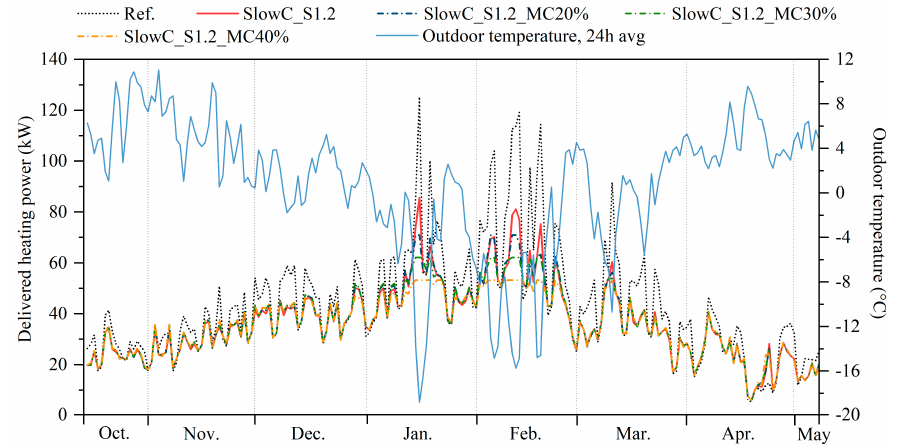
Figure 12. Heating season (14 October–7 May) daily maximum hourly peak power.